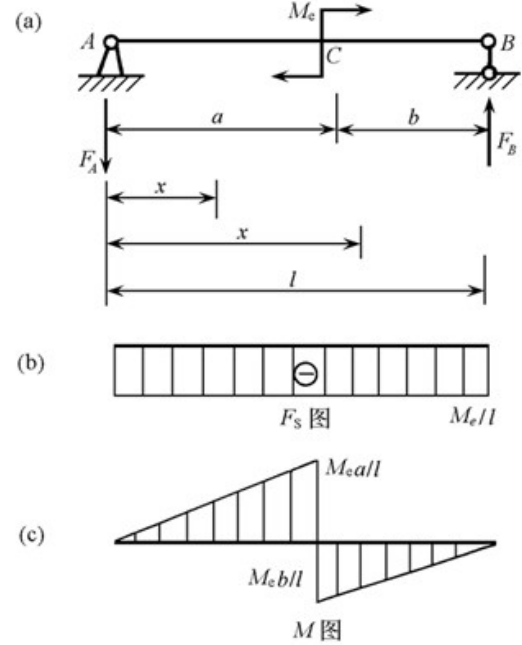
Fig. 9 Shear and bending moment diagram of main